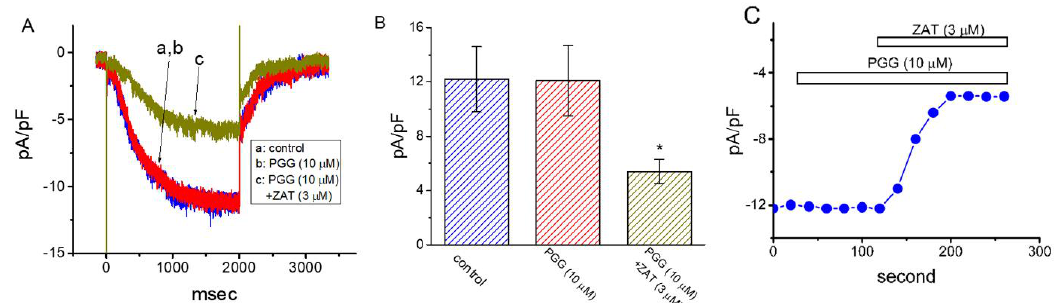
Figure 7. Inability of PGG to perturb the hyperpolarization-activated cation current ( I h ) identified from GH 3 cells. In this set of experiments, cells were bathed in a Ca 2 + -free Tyrode’s solution that contained 1 µ M tetrodotoxin, and the electrode was filled up with K + -containing solution. ( A ) Representative I h densities obtained in the control, and during the exposure to 10 µ M PGG or 10 µ M PGG plus 3 µ M zatebradine (ZAT). In the experiments on PGG plus zatebradine, as the cells were continually exposed to PGG, further addition of zatebradine was applied. ( B ) Summary bar graph showing the e ff ects of PGG and PGG plus zatebradine (ZAT) on the density of hyperpolarization-evoked I h (mean ± SEM; n = 7 for each bar). Each current density in ( A , B ) was taken at the end of 2-sec hyperpolarizing step to − 120 mV from a holding potential of − 40 mV. The statistical analyses were done by ANOVA-1, p < 0.05, followed by post-hoc Fisher’s least-significant di ff erence test, p < 0.05. * indicates a significant di ff erence from control ( p < 0.05). ( C ) Time course of e ff ect of PGG (10 µ M) and PGG (10 µ M) plus ZAT (3 µ M) on I h density. I h density was taken at the end of 2-sec hyperpolarizing step from − 40 to − 120 mV.